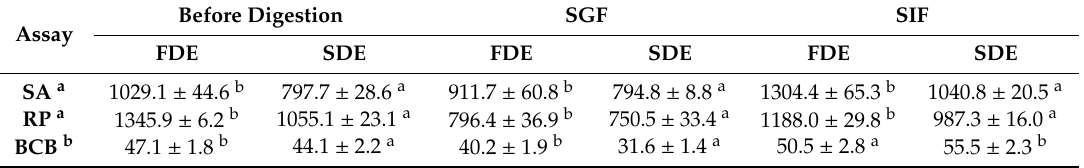
Table 2. Antioxidant activity of FDE and SDE before and after in vitro gastrointestinal digestion. Before Assay